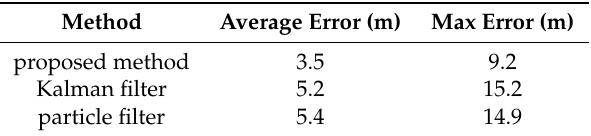
Table 3. The average and maximum positioning error comparisons if 10% of outliers in Wi-Fi fingerprinting are added.